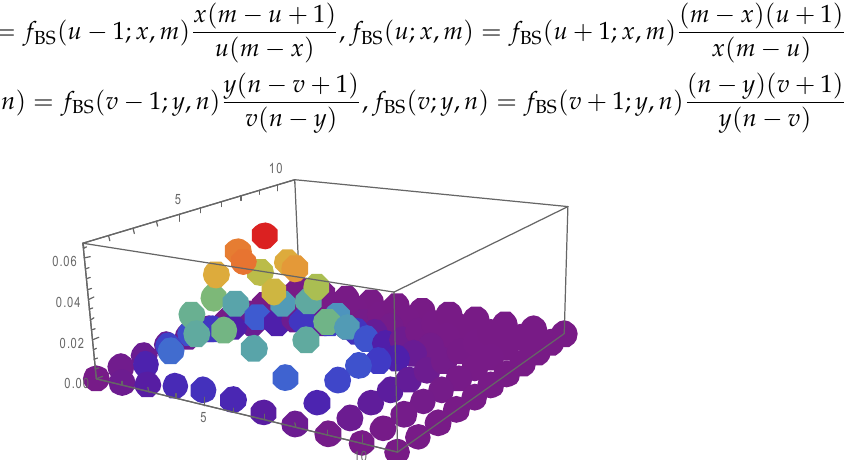
Figure 4. f B2E ( x , y ,3,4,10,10 ) probability mass